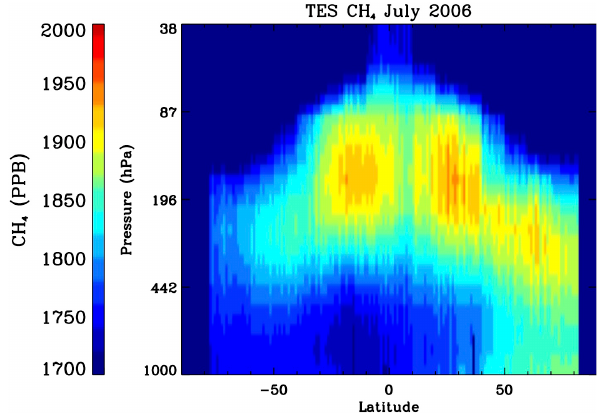
Figure 10: TES tropospheric methane, averaged over all longitudes. Fig. 10. TES tropospheric methane, averaged over all